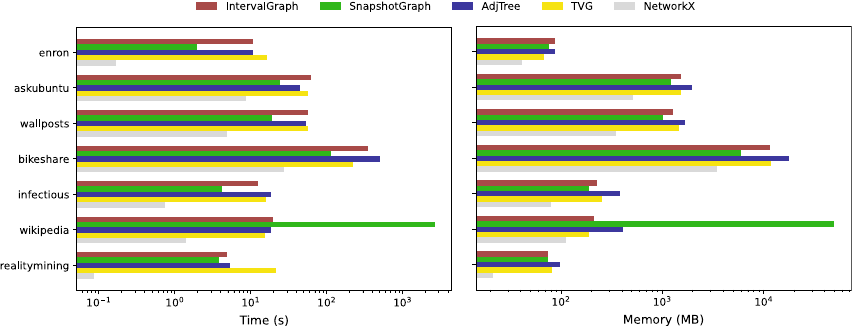
Fig. 3 Creation times and memory usage for different temporal network data structures. The NetworkX MultiGraph is the simplest data structure and has the lowest creation time and memory usage (at the cost of slow time-based slice times as shown in Fig. 2). All other data structures have roughly comparable creation times and memory